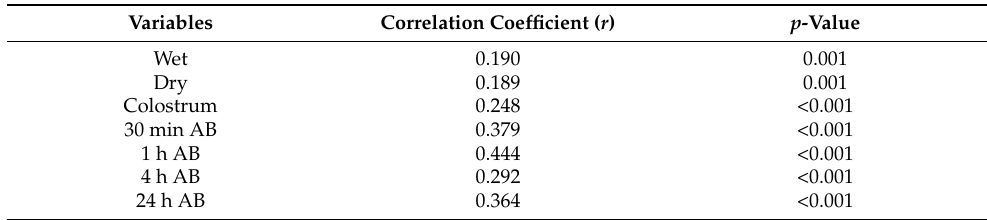
Table 9. Significant correlations between puppies’ weight and their superficial temperature in UPL thermal window.